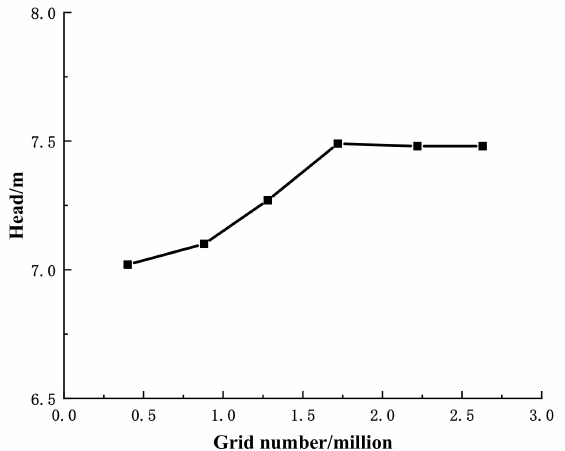
Figure 2. Grid of automotive electronic water pump: ( a ) inlet section, ( b ) impeller, and ( c ) volute and outlet.